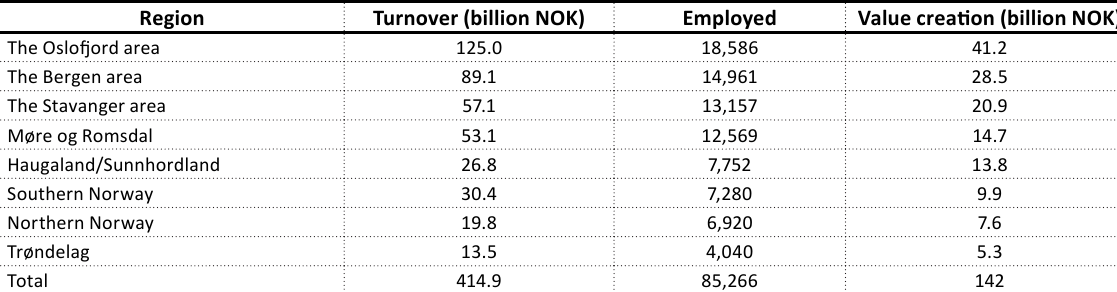
Table 2. Regionally distributed key figures for the maritime industry in 2018